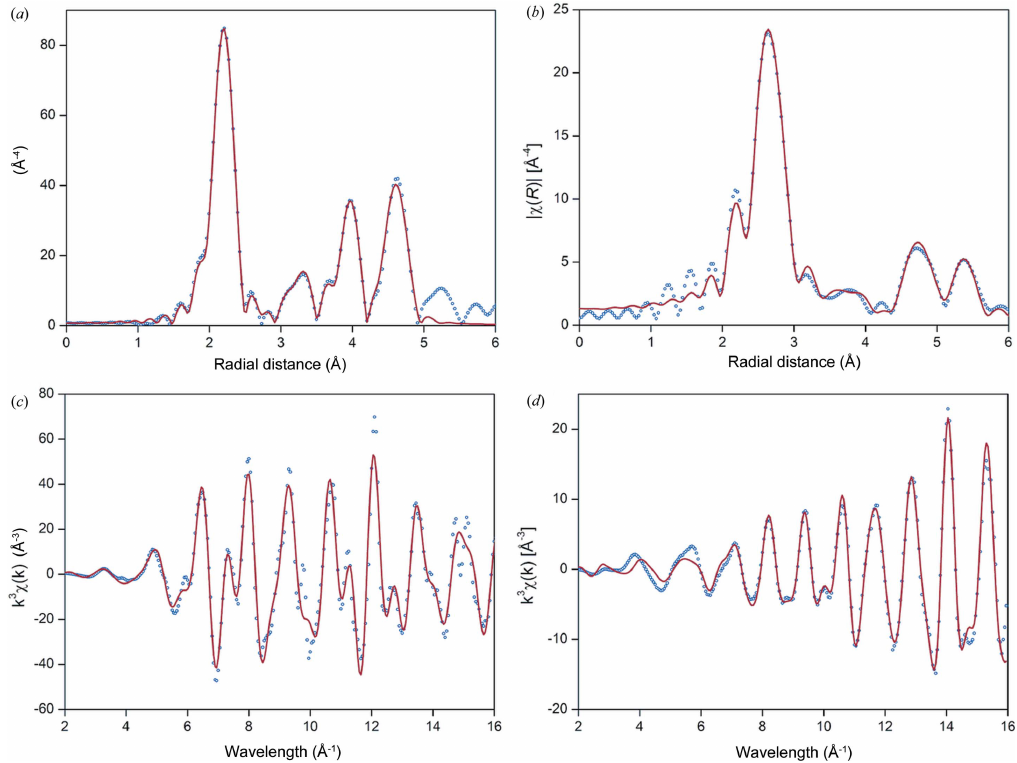
Figure 6 Radial distances determined using EXAFS for ( a ) Ni and ( b ) Pt, and the corresponding k -plots for ( c ) Ni and ( d ) Pt show good agreement with the PDF- determined correlation lengths. The dotted (blue) spectra are the measured data and the line (red) spectra is the fitted